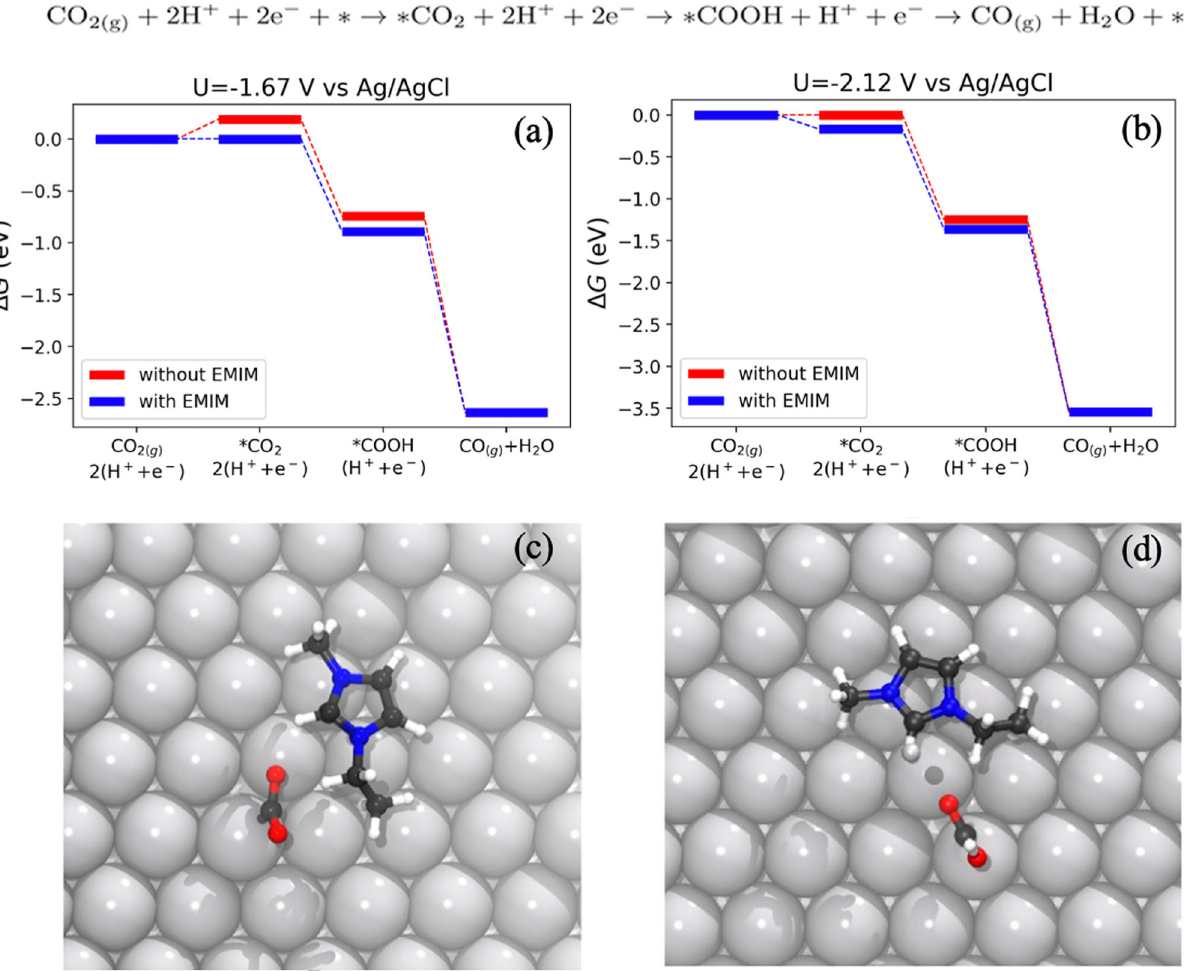
Fig. 6 CO 2 RR reaction path to CO in acetonitrile. a − 1.67 V vs. Ag/AgCl and ( b ) − 2.12 V vs. Ag/AgCl, on Ag(111) surface with and without [EMIM] + . The reaction pathway was described in the presence (blue) or absence (red) of [EMIM] + . Top view of intermediate state geometries for the activation of CO 2 ( c ) and adsorption of COOH ( d ) on Ag(111) surface in the presence of [EMIM] + . Ag atoms are represented in gray, C atoms in black, O atoms in red, N atoms in blue and H in white.